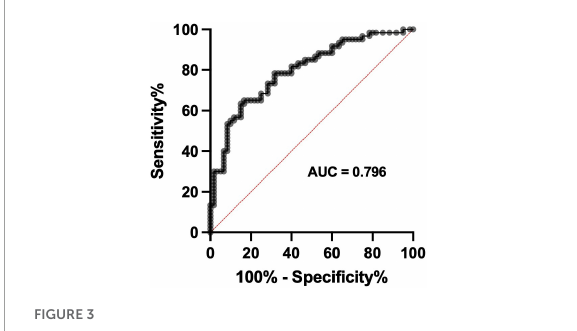
FIGURE3 Receiver operator characteristic curve for wet-weight cerebral Na levels. Data represents wet-weight cerebral-Na measurement in all regions that displayed significant case-control Na perturbations. n = 120 (Con = 60; VaD =